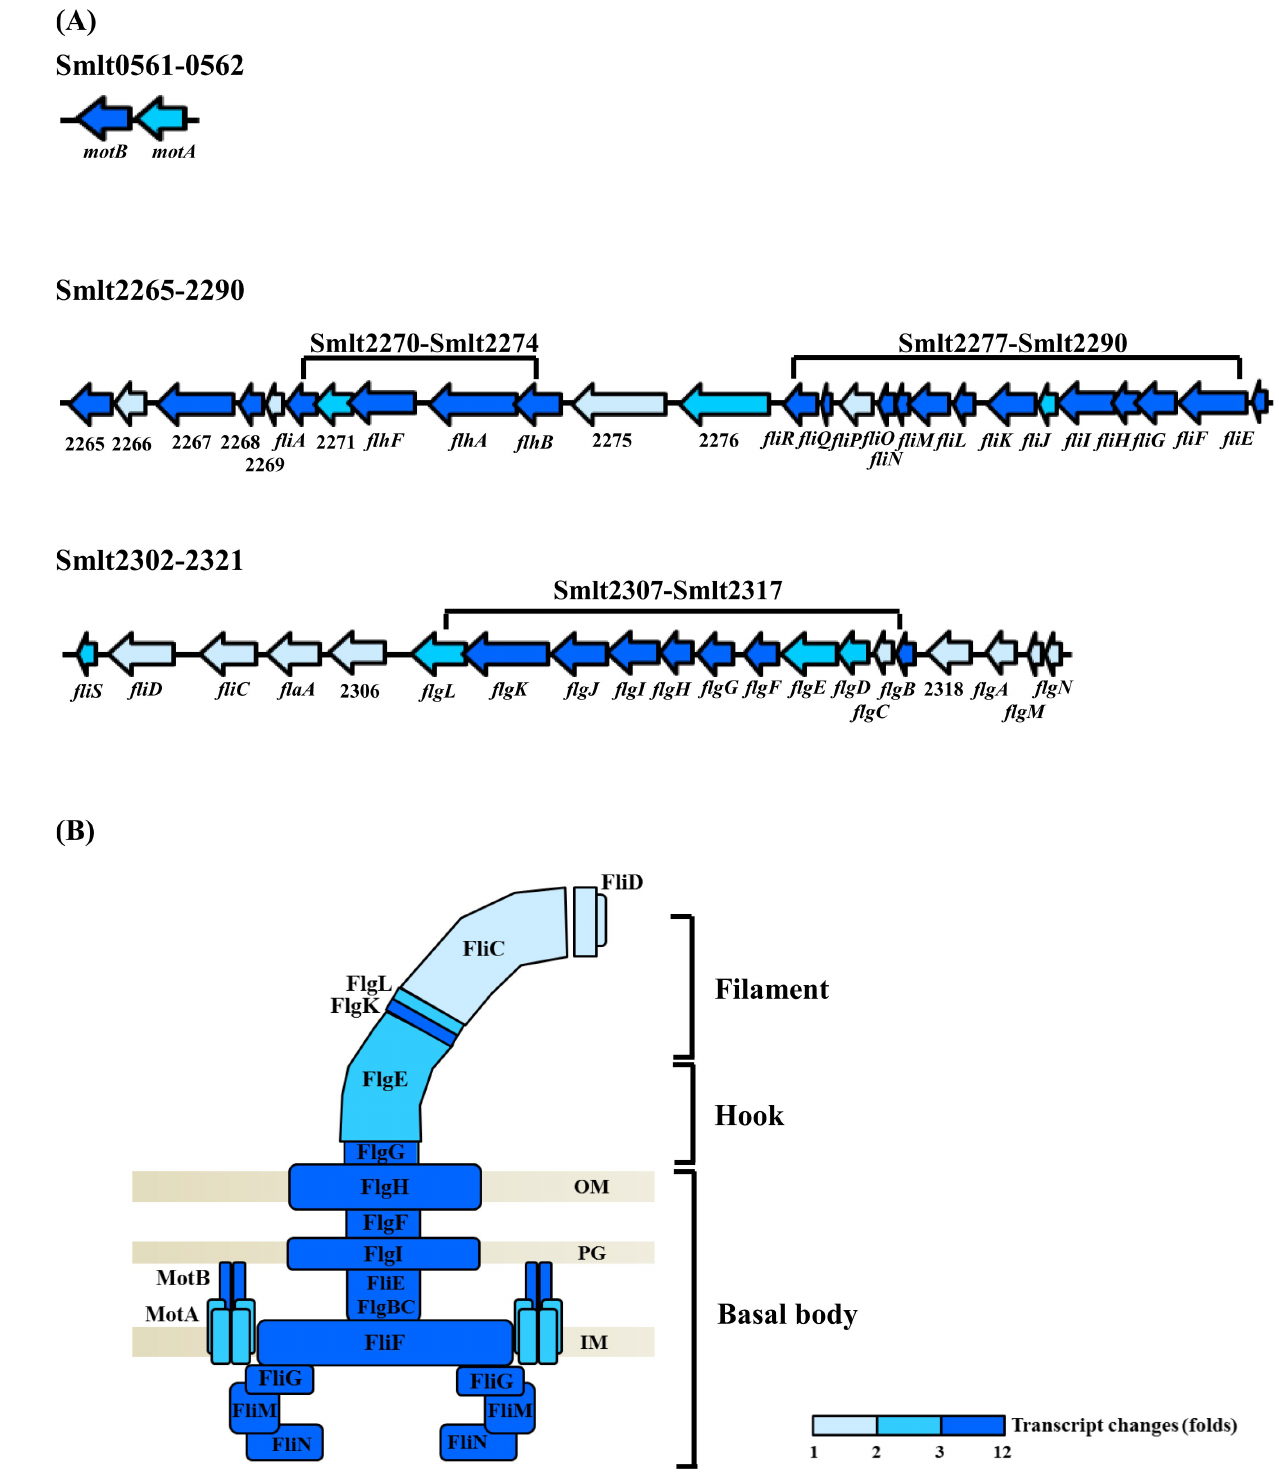
Fig 4. The transcript changes (folds) of flagella-related genes between KJ and KJ Δ BCcells by transcriptome analysis. Total mRNA was extracted from KJ and KJ Δ BC logarithmic-phasecultures. The ribosomal RNA (rRNA) depletion,adapter-ligatedcDNA library construction and enrichment, and cDNA sequencing were performed as describedin Materials and Methods. Transcript changes(folds) of a geneis expressedas the transcript in KJ Δ BC relative to the transcript in wild-typeKJ (KJ Δ BC/KJ). Navy blue color indicatesthe transcript